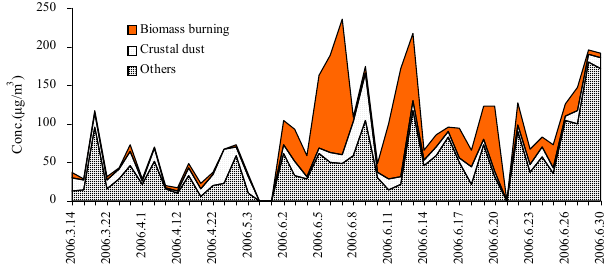
, NO − , and NH + in aerosols at 4 3 4